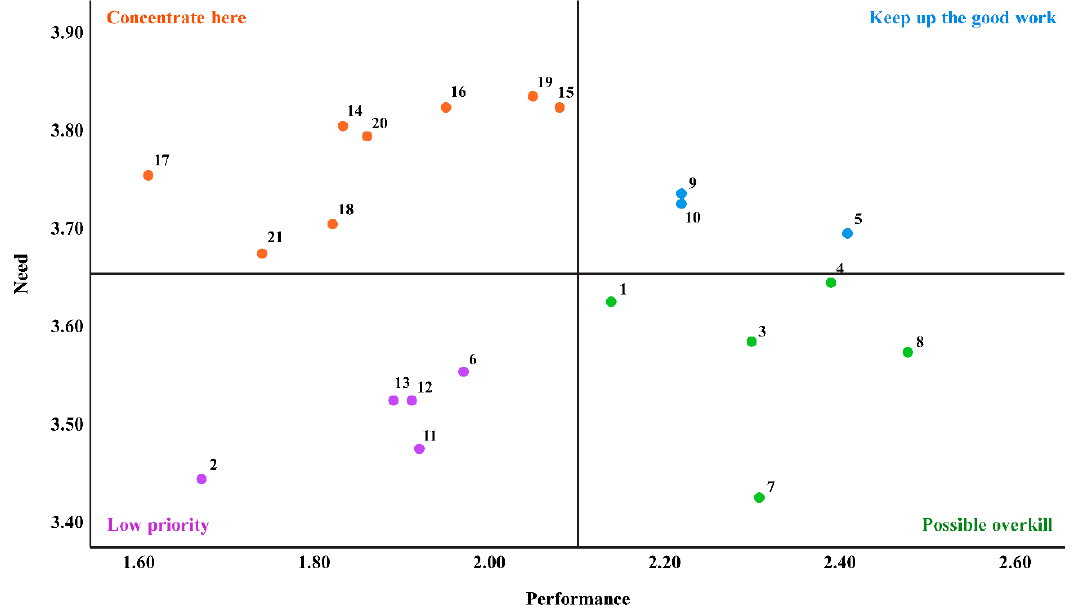
Figure 1. Importance-performance analysis matrix of newborn intensive care training need and ex- perience.